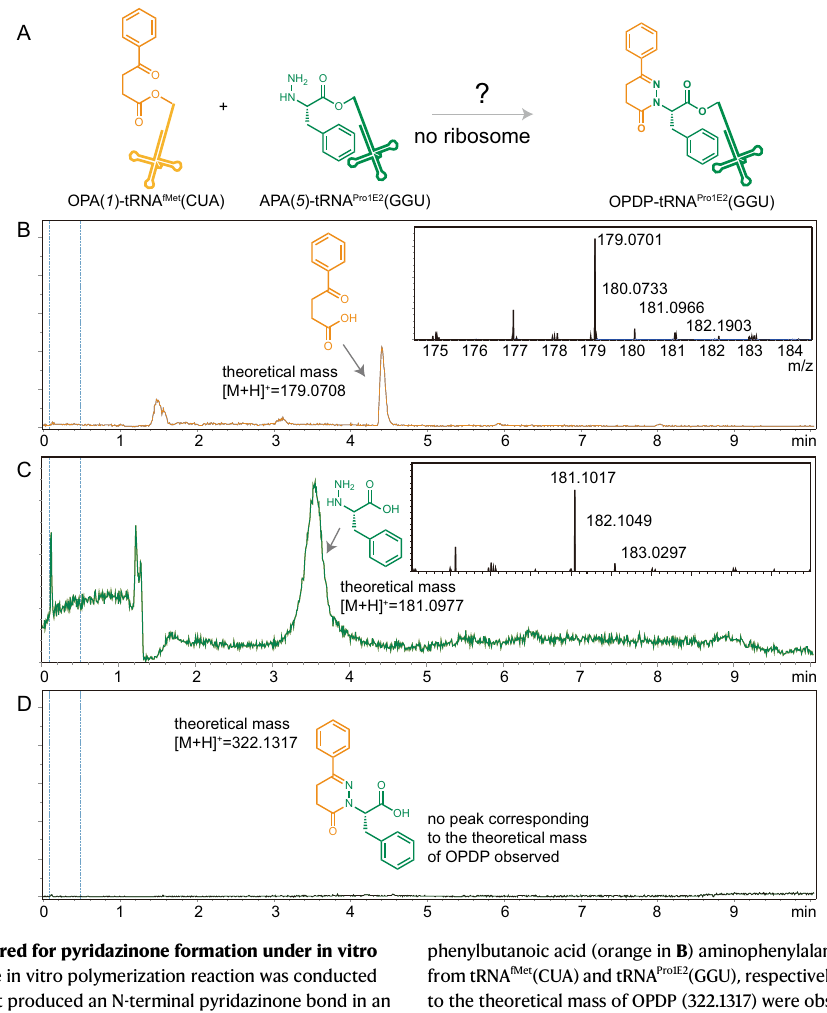
phenylbutanoic acid (orange in B ) aminophenylalanine (green in C ) hydrolyzed fromtRNA fMet (CUA)and tRNA Pro1E2 (GGU),respectively. D Nospeciescorresponding to the theoretical mass of OPDP (322.1317) were observed in the reaction mixture. The extracted ion chromatograms were obtained based on theoretical average masses (Supplementary Information). Spectra are representative of n =3 inde- pendent